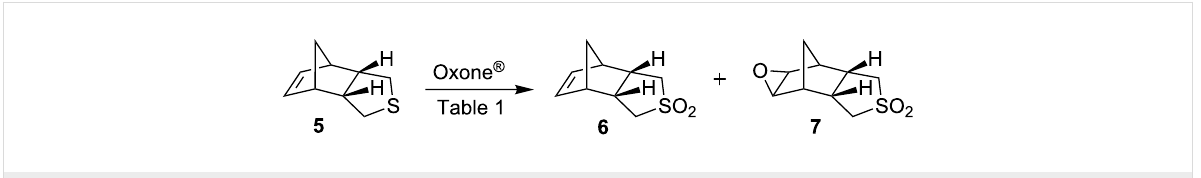
Scheme 1: Preparation of the sulfone 6 via oxidation.